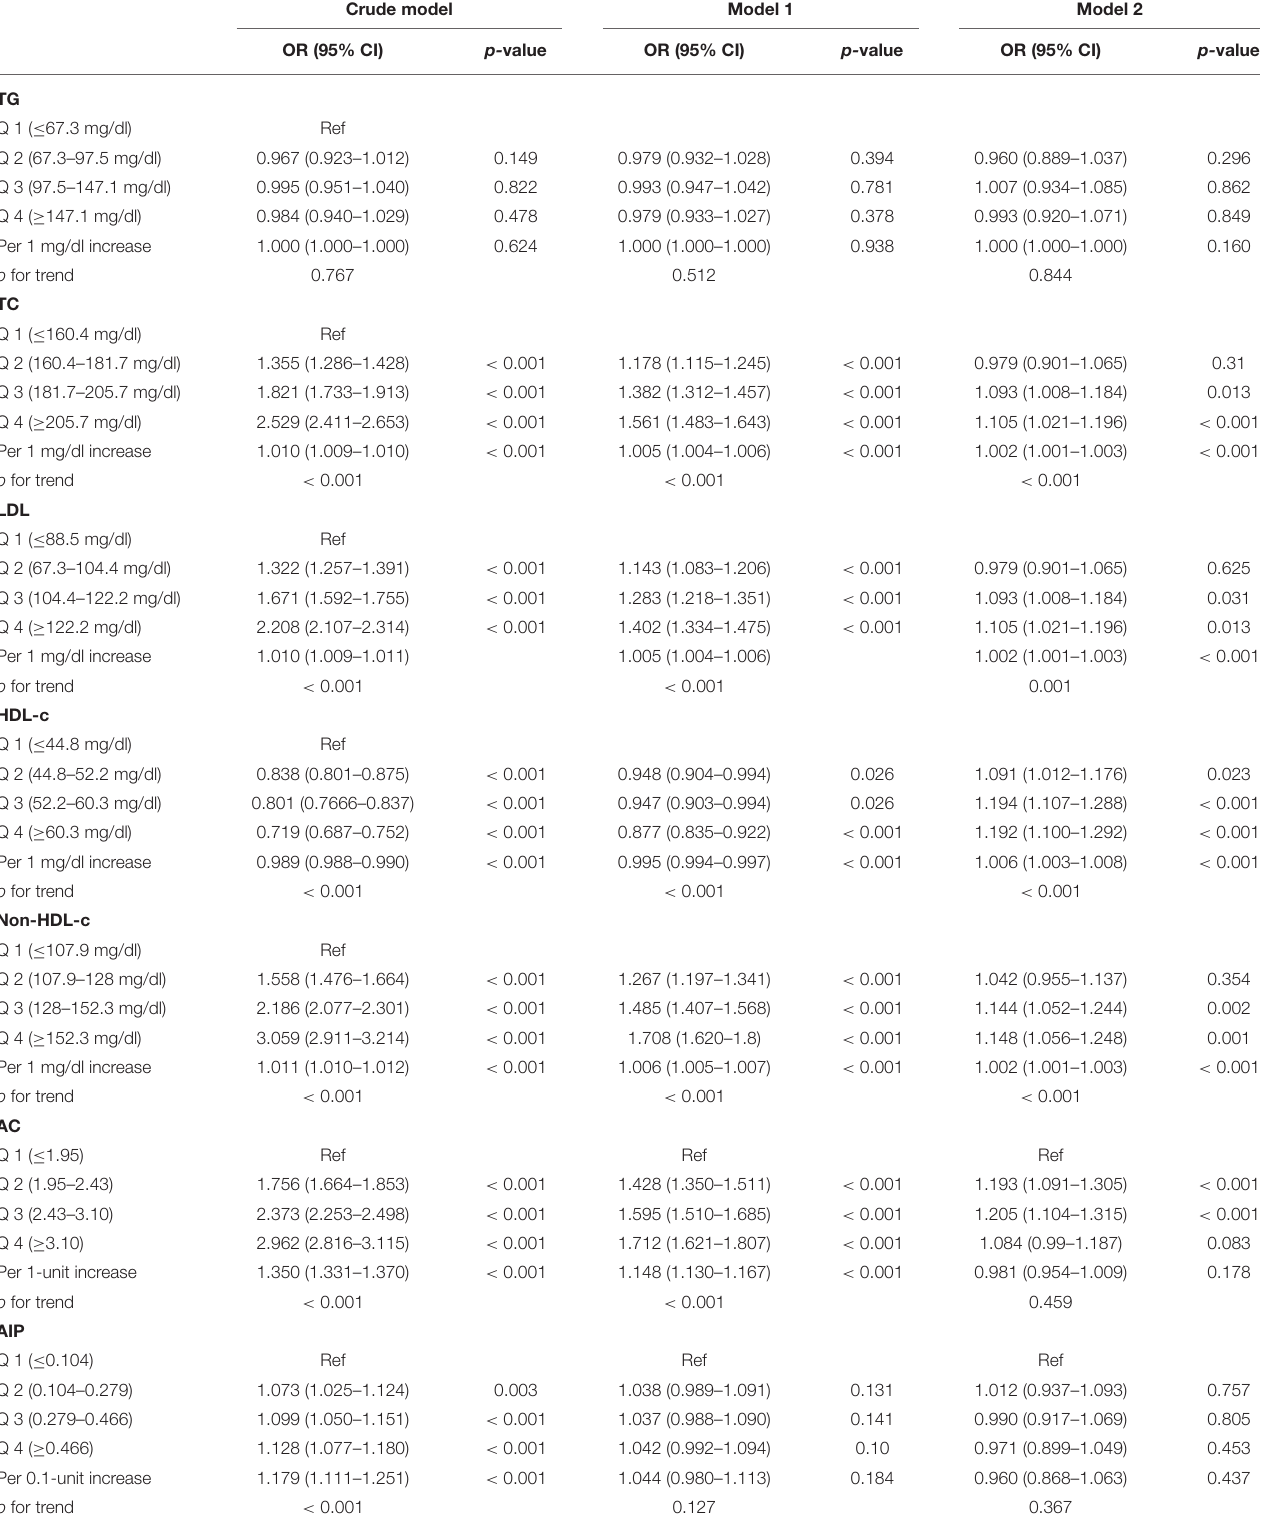
TABLE 3 | Multivariable logistic regression model evaluating the association between serum lipid levels and